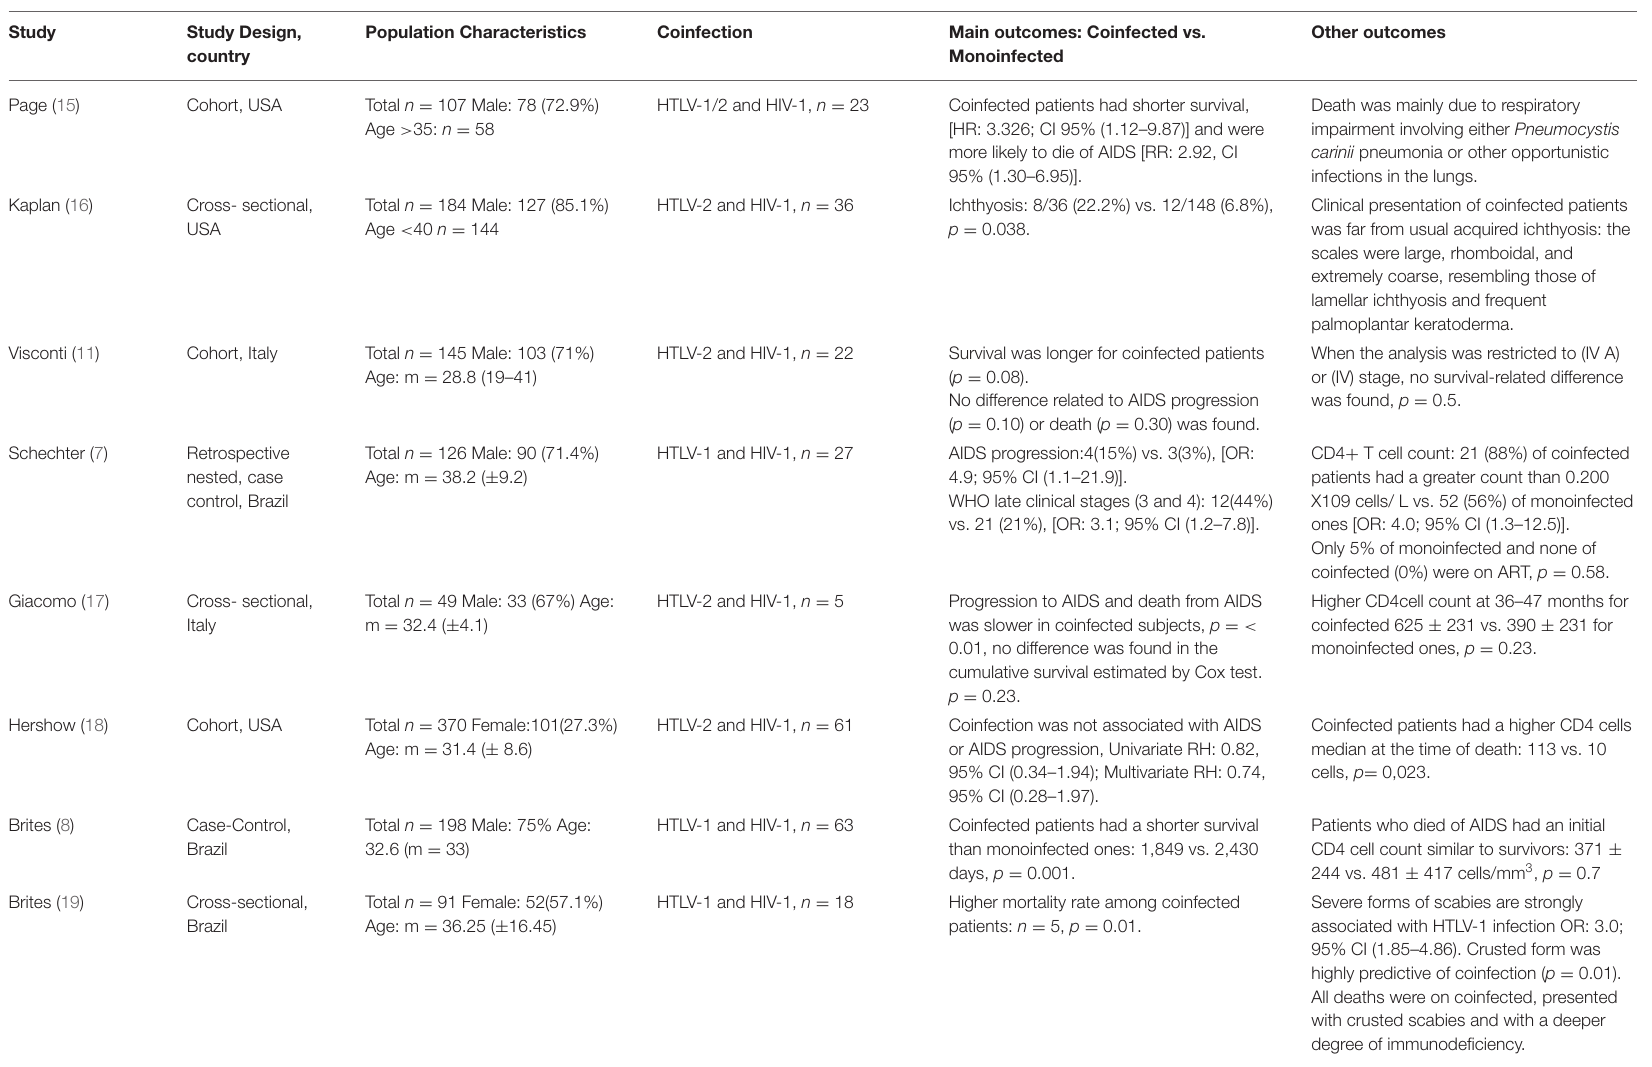
TABLE 2 | Summary of the included studies related to HIV-1 and HTLV-1/2